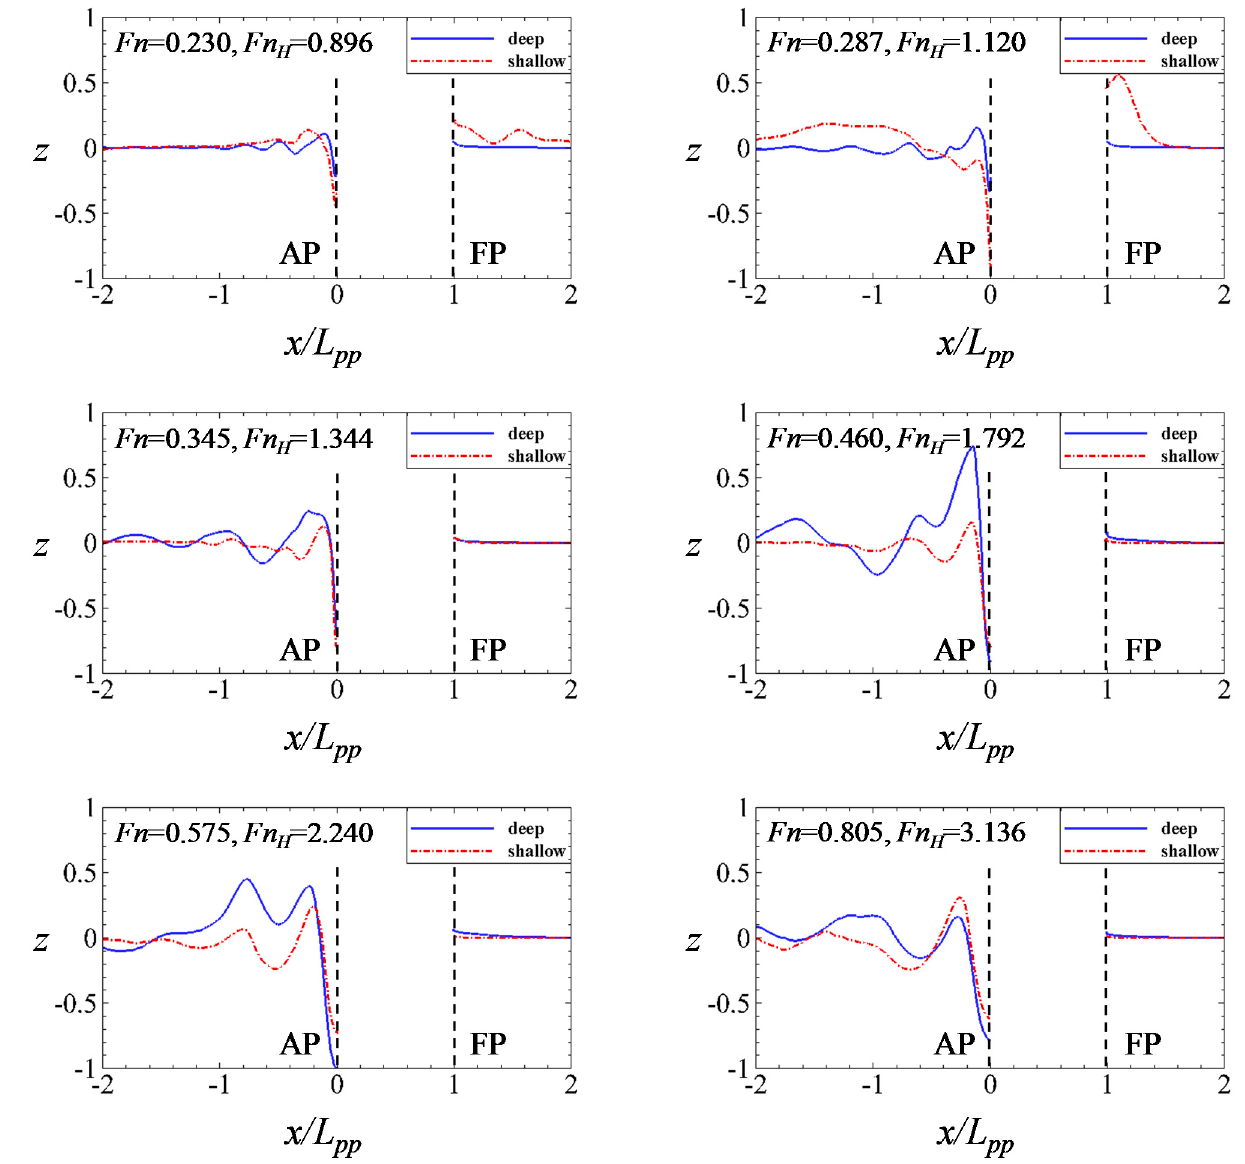
Figure 17. Comparison of the longitudinal wave cuts at the mid-plane of the demihull in deep and shallow water.